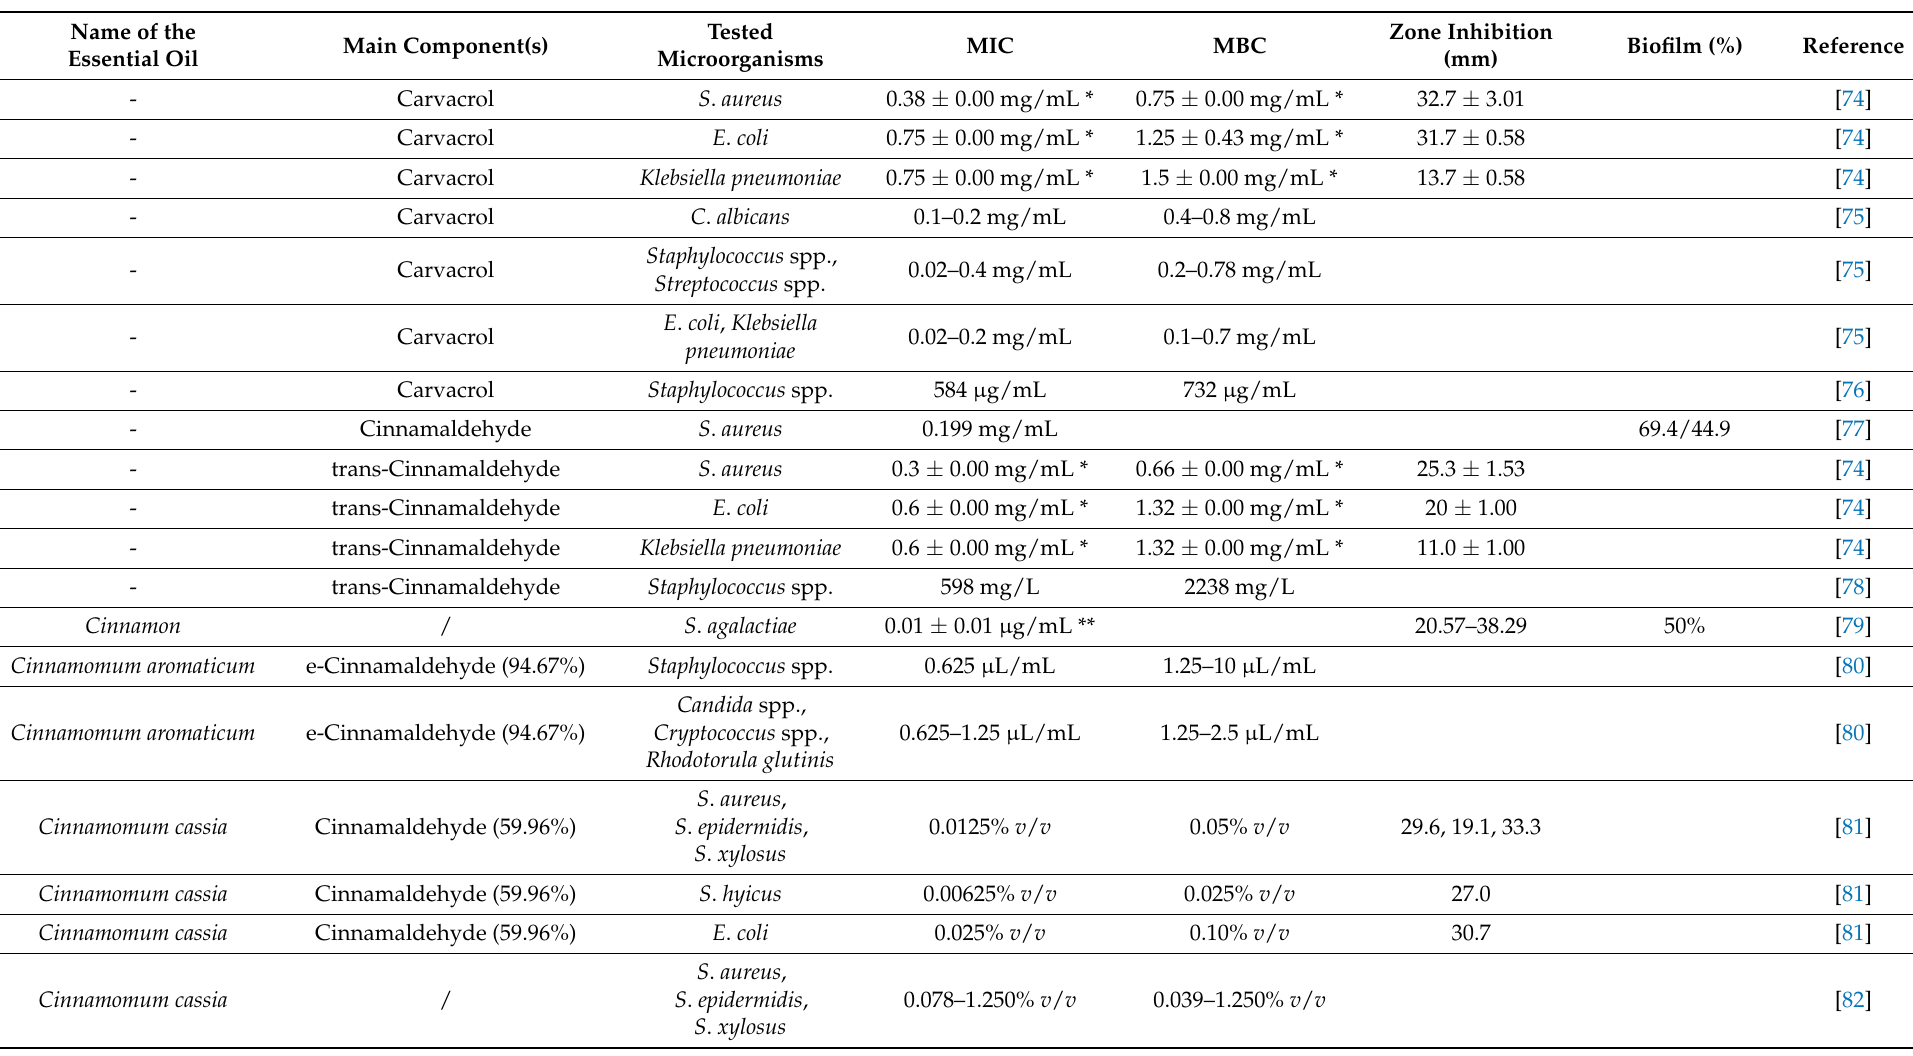
Table 1. List of selected essential oils and their major constituents with in vitro activity (for an expanded list, see Supplementary